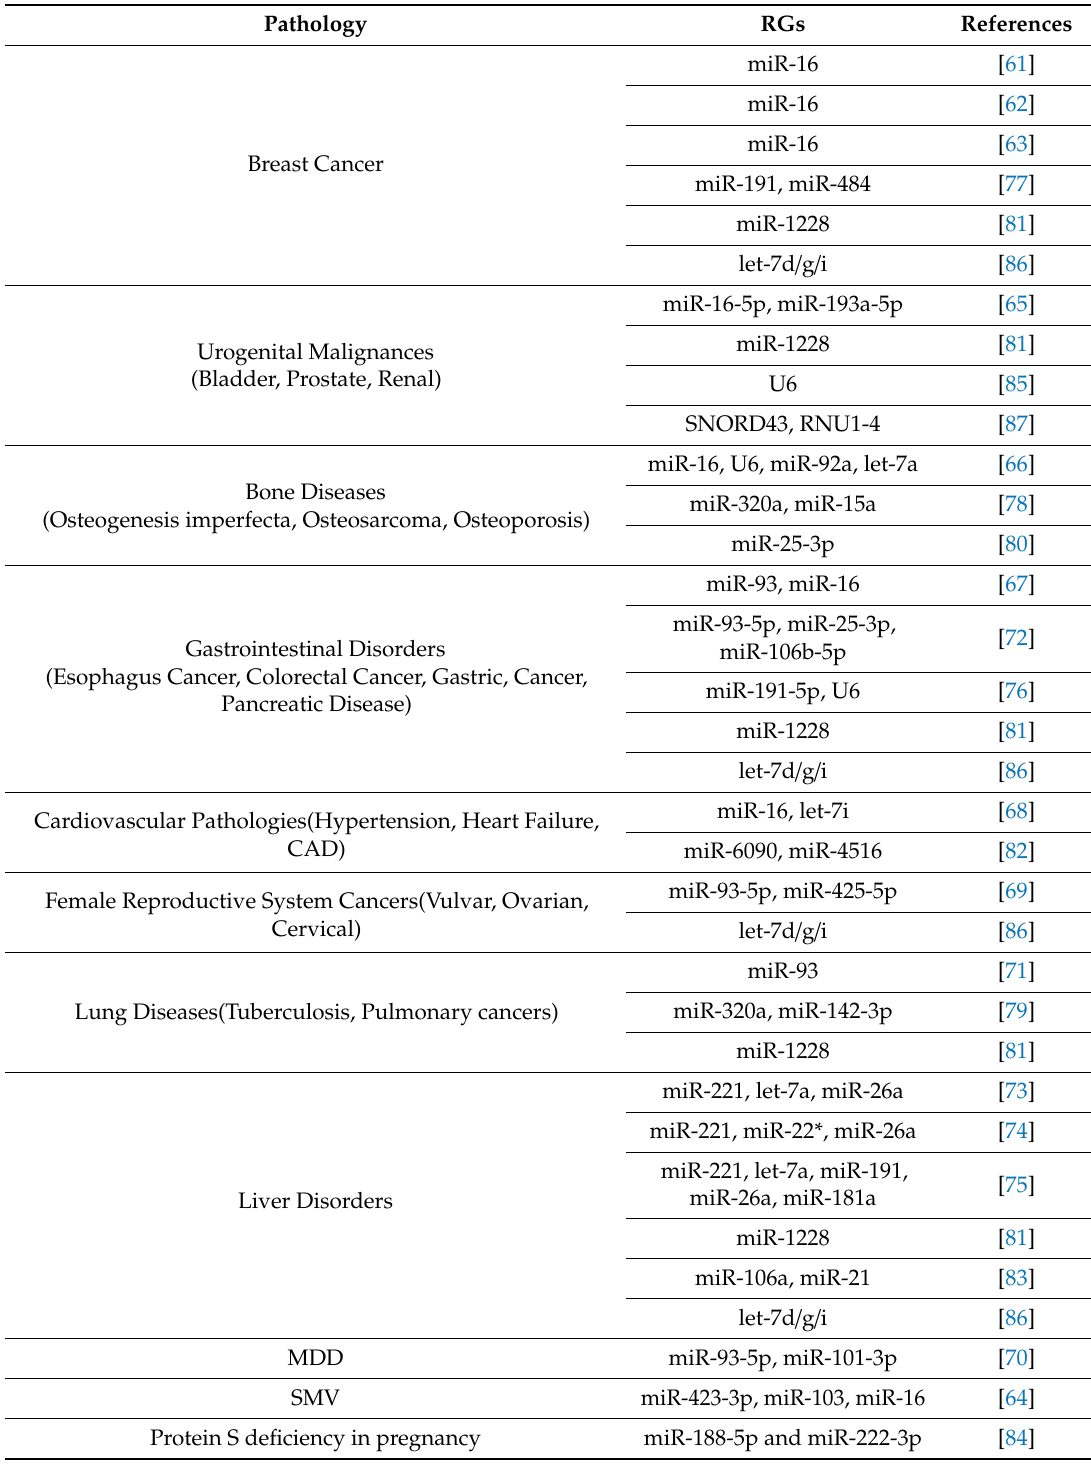
Table 2. RGs Pathology-based RG